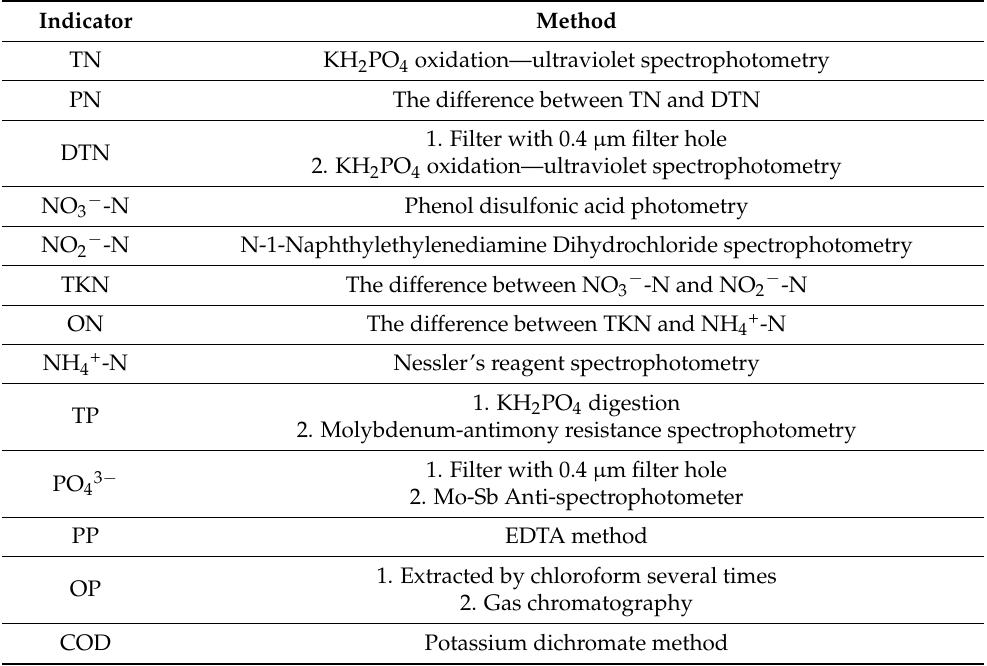
Table 3. The determination methods of pollutants.